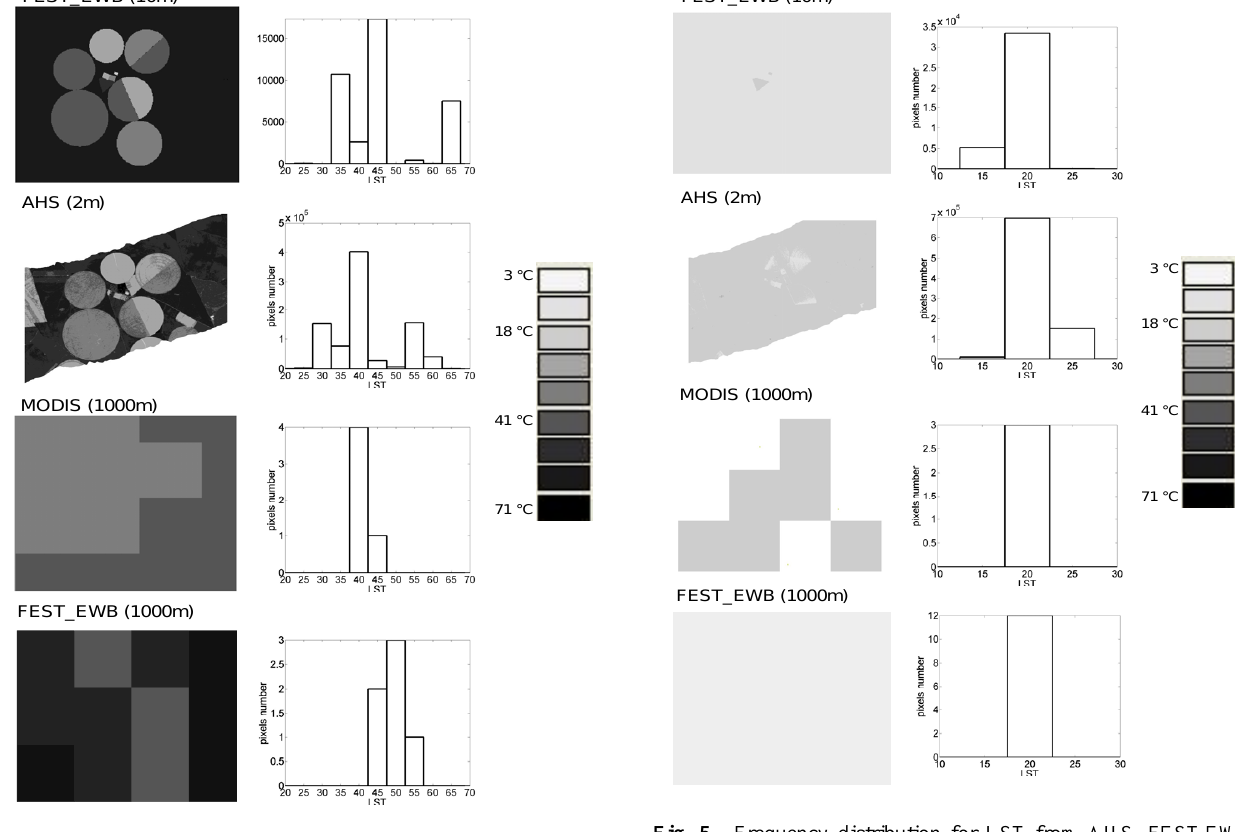
Fig. 4. Frequency distribution for LST from AHS, FEST-EWB (10m–1000m) and MODIS for 13 July at 13:45.